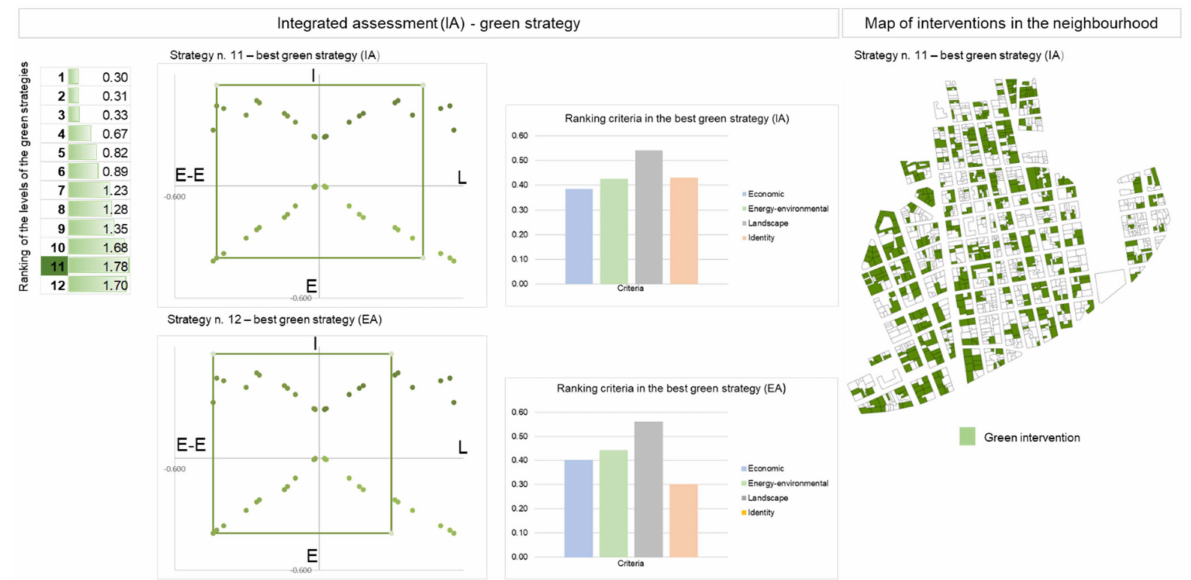
Figure 5. Ranking of the levels of the green strategy based on the aggregate assessment; comparison between the two levels of the strategy in economic terms and the integrated assessment; visualization of the ranking of the criteria for the best economic level and the integrated evaluation; map displaying the best level of the green